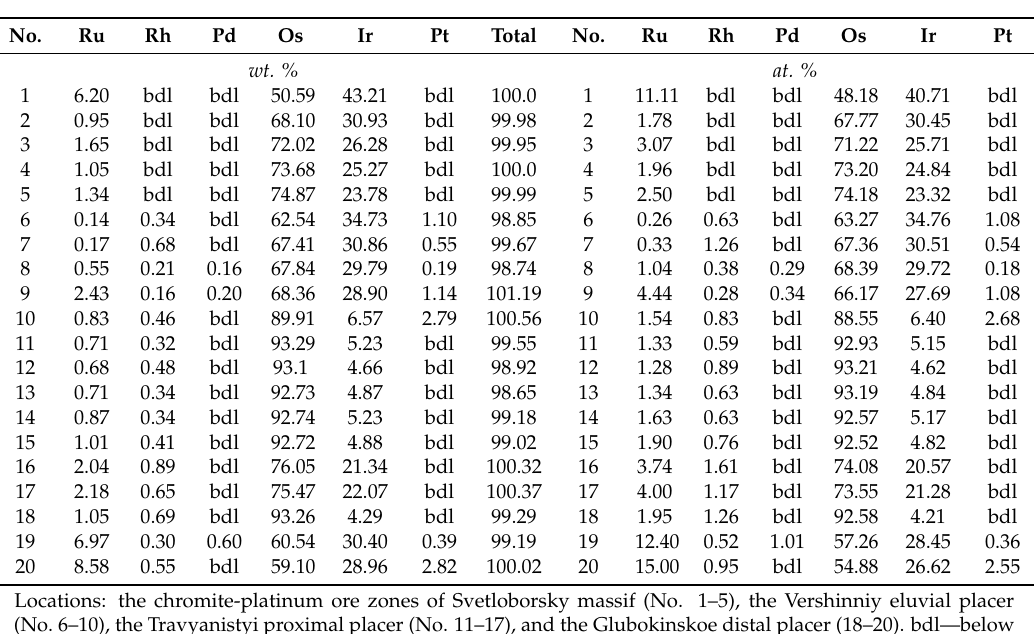
Table 3. Composition of osmium from the chromite-platinum ore zones of Svetloborsky massif and associated placers.